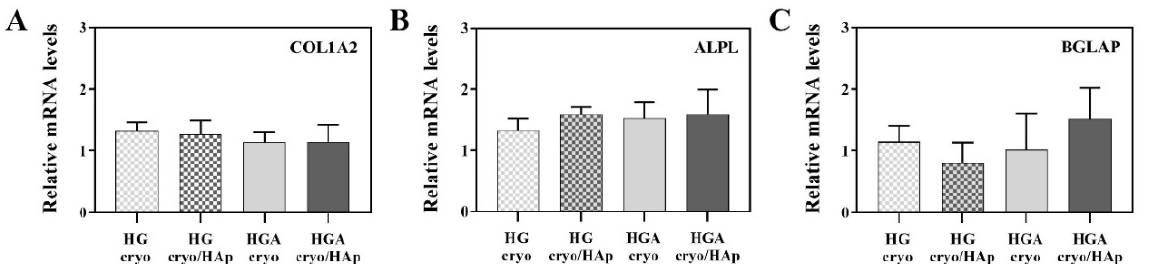
Figure 7. Gene expression levels of collagen type 1 (COL1A2) ( A ), alkaline phosphatase (ALPL) ( B ), and osteocalcin (BGLAP) ( C ) in hMSCs that were cultured for 28 days in an osteogenic medium on the cryogelated scaffolds (HG cryo , HG cryo /HAp, HGA cryo , HGA cryo /HAp) show no differences between the groups. Values were normalized to GAPDH as the housekeeping gene and are expressed as fold change relative to the average across all groups, which were set to 1. Values represent the mean ± SD ( n = 3/group).